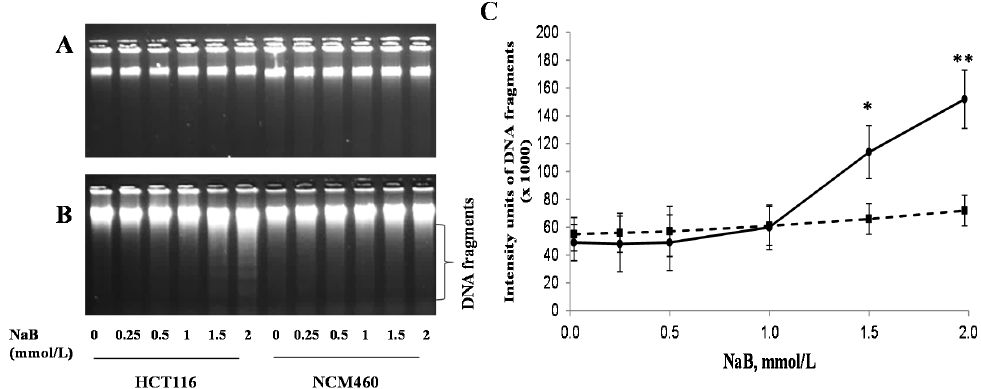
Figure 3. Effect of sodium butyrate (NaB) on the genomic DNA fragmentation of cancerous HCT116 and non ‐ cancerous NCM460 colon cells. A representative DNA image showing DNA fragmentation at ( A ) 1.5 h; ( B ) 15 h; ( C ) the intensity signals of genomic DNA fragmentation (at 15 h) of cancerous HCT116 (solid lines) and non ‐ cancerous NCM460 (dashed lines) colon cells were analyzed by the UVP Bioimaging Systems (there was no DNA fragmentation at 1.5 h). Values are means ± SD, n = 4. There was a significant interaction between cell type and concentration ( p < 0.0001) by two ‐ way ANOVA. * Different from HCT116 control (0 mmol/L NaB); * p < 0.05, ** p < 0.0001.